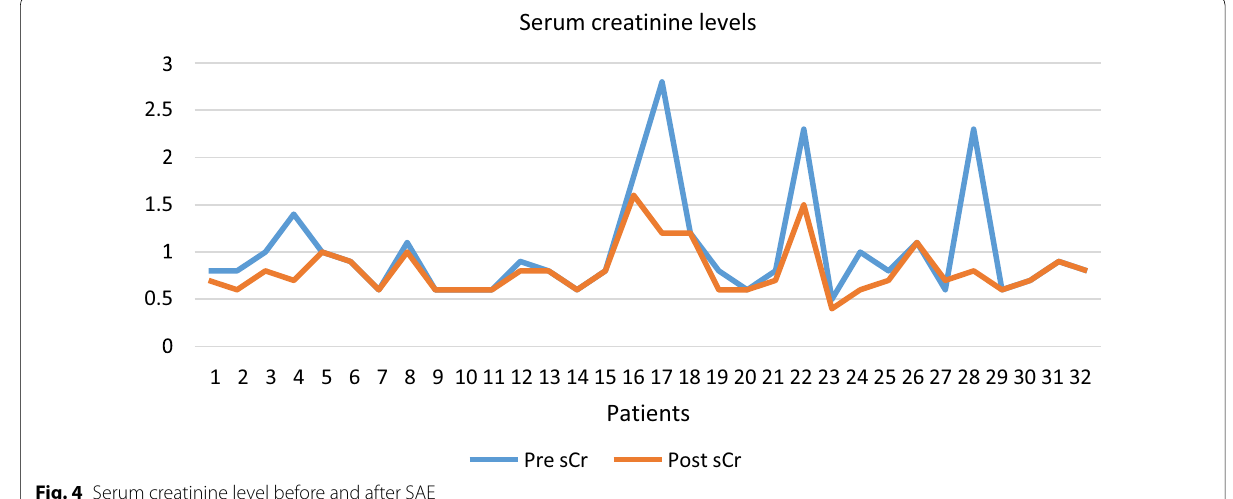
Fig. 4 Serum creatinine level before and after SAE